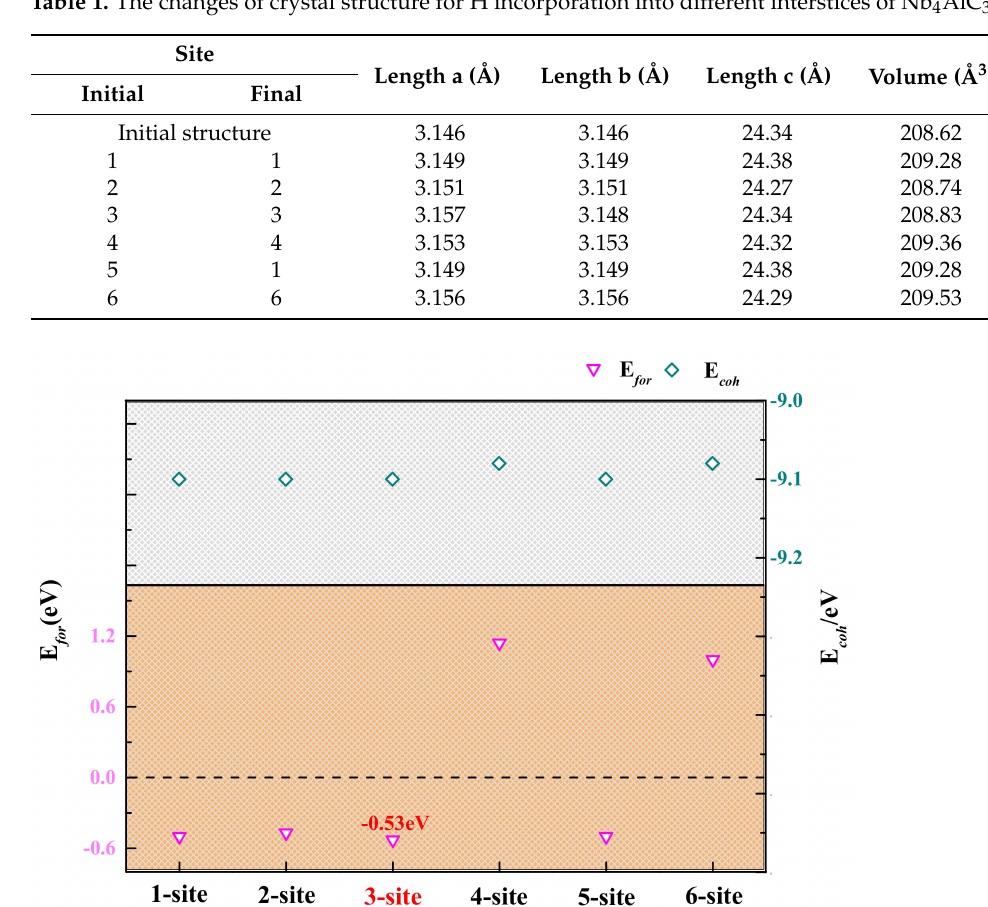
Figure 2. E coh and E for for H incorporation into different interstices of Nb 4 AlC 3